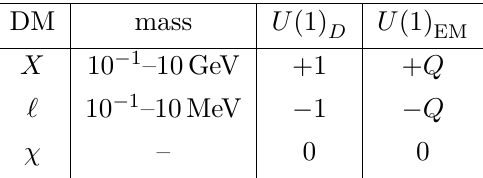
Table 1 . Masses and charges of the dark sector particles X , ‘ (the MCPs) and χ (the unspeci- fied